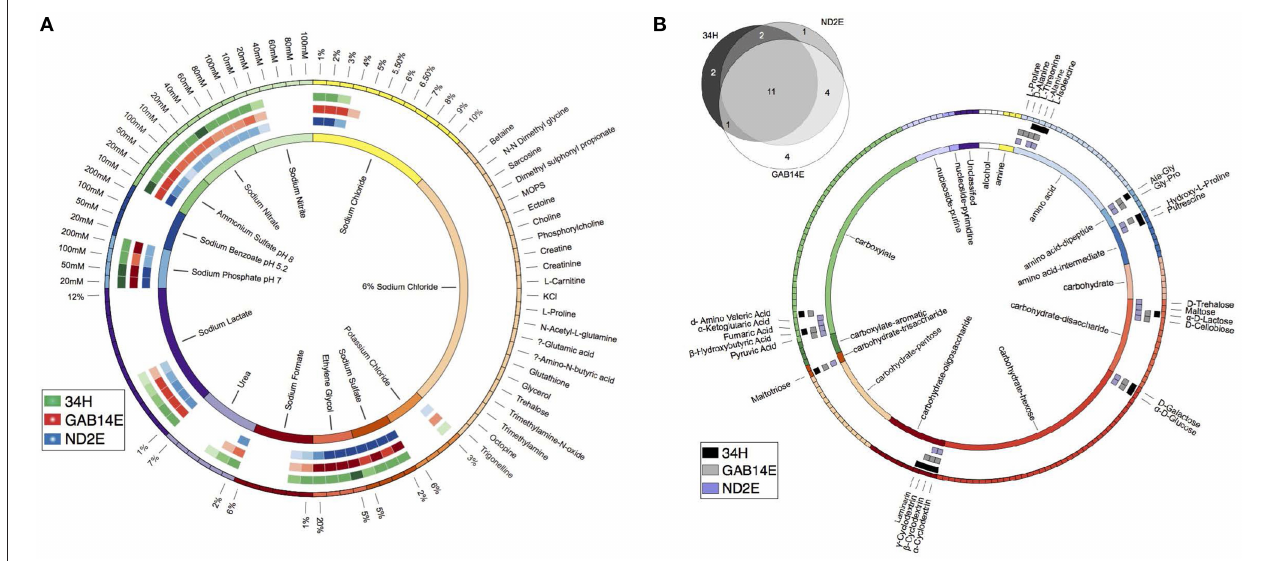
FIGURE 3 | Phenotypic characterization of three C. psychrerythraea isolates. (A) Salt tolerance. The boxes on the outer circle represent each of the 90 salt concentrations tested. Colors represent groups of salts. Boxes in circles two, three, and four represent salt concentrations that allowed for measurable metabolism (OD 560 > 0.5). Colors in circles two, three and four correspond to the isolate. Green corresponds to 34H, blue corresponds to ND2E and red corresponds to GAB14E. The inner circle represents the salt groupings with labels. (B) Venn Diagram showing the number of shared carbon sources between the isolates. Detailed description of the carbon sources able to support metabolism of each isolate. The boxes on the outer circle represent each of the 190 carbon sources tested. Colors represent carbon source class and are detailed in the inner circle. Boxes in circles two, three, and four represent a carbon source that could support growth of an isolate. Colors in circles two, three, and four correspond to the isolate. Black corresponds to 34H, gray corresponds to ND2E and purple corresponds to GAB14E. The inner circle represents the carbon source groupings with labels.